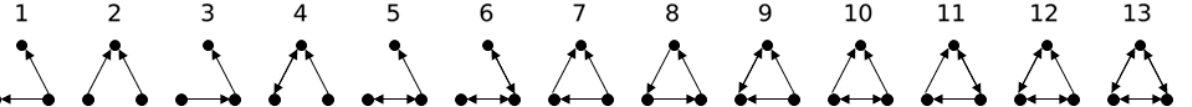
Figure 1. The 13 possible connected triads in a directed network. We disregard three other triads which have isolated (unlinked) nodes. For each triad type, we tabulate the number of times the triad appears in an empirical network and compare that to an expected value to generate a triad significance profile, or TSP.